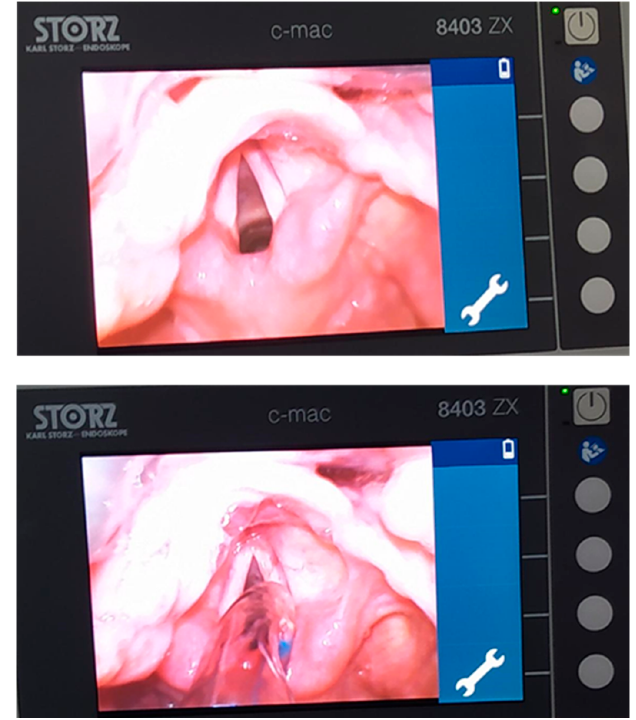
Figure 5. Similar example of VDL photographs obtained with C-Mac during an endotracheal intubation in a real patient. Top: photography during visualization of the buccal cords. Bottom: photograph of the introduction of the endotracheal cannula through the buccal cords.